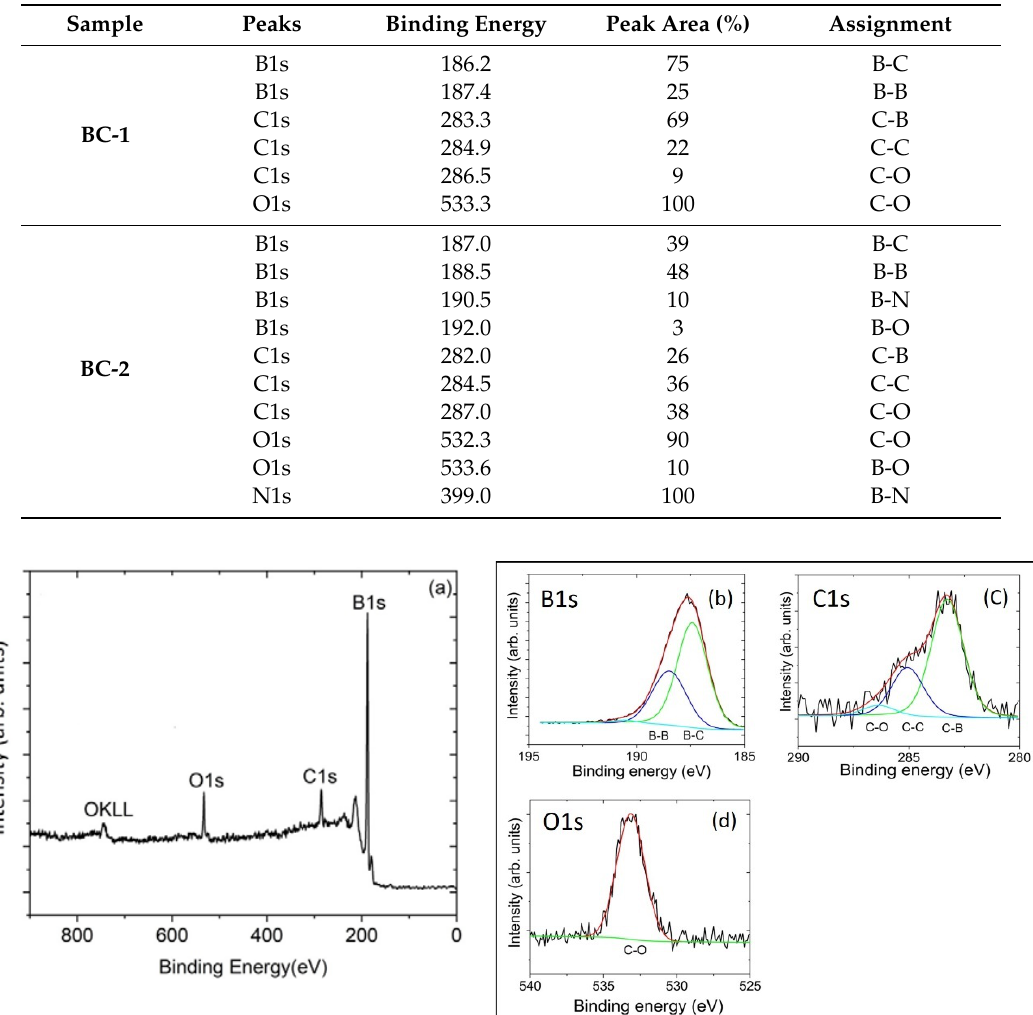
Table 1. X-ray photoelectron spectroscopy compositional analysis and fitted parameters of B1s, C1s, O1s, and N1s of BC-1 and BC-2 samples. “Data from reference [38–43].”